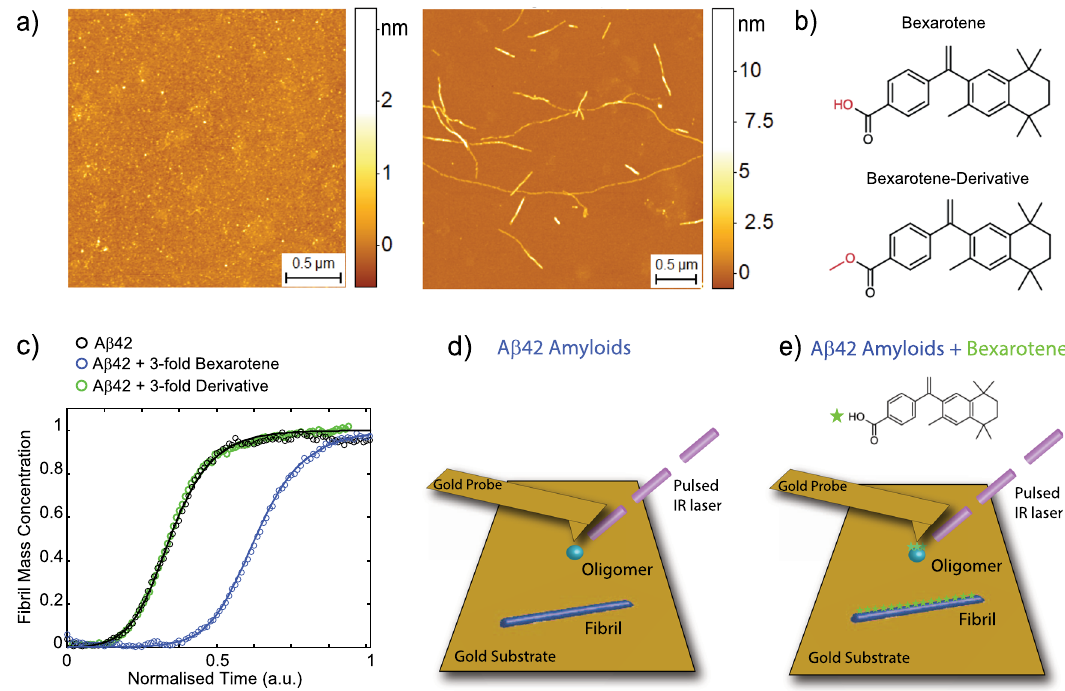
Fig. 1 Effect of bexarotene on the aggregation kinetics of A β 42. a Representative high-resolution AFM morphology maps of A β 42 aggregates before incubation (0 h) and at the end of the aggregation reaction (4 h). The morphology of the aggregates was reproducible and consistent on at least fi ve independent and randomly chosen areas on the surface of each sample. b Structures of bexarotene and its derivative, where the hydroxyl group is replaced with a methyl group (highlighted in red). c Kinetics pro fi les of the aggregation reaction of 2 μ M A β 42 in the absence or in the presence of a 3:1 concentration ratio of bexarotene or its derivative. The solid lines show the best fi t of the experimental data (open circles) when primary and secondary pathways are both inhibited by bexarotene. d , e Schematic of the AFM-IR experimental approach to study the interaction of A β 42 oligomers (light blue sphere) and fi brils (dark blue rod) with bexarotene (green star) at the single aggregate scale. To reach high sensitivity off-resonance, small pulse ORS- nanoIR at the nanogap between a gold-coated probe and a gold substrate was used 38